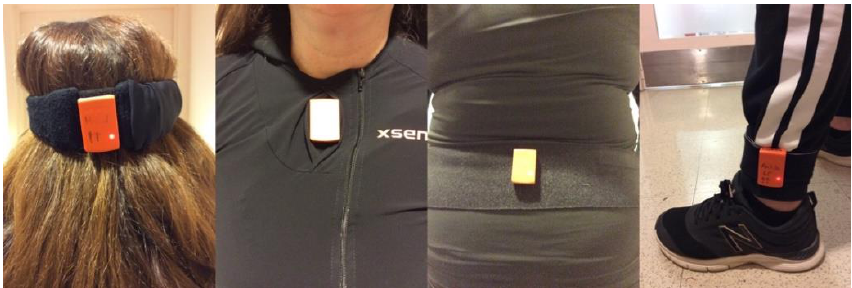
Figure 1. Five inertial sensors were donned on the head, upper trunk, pelvis, left and right ankles.